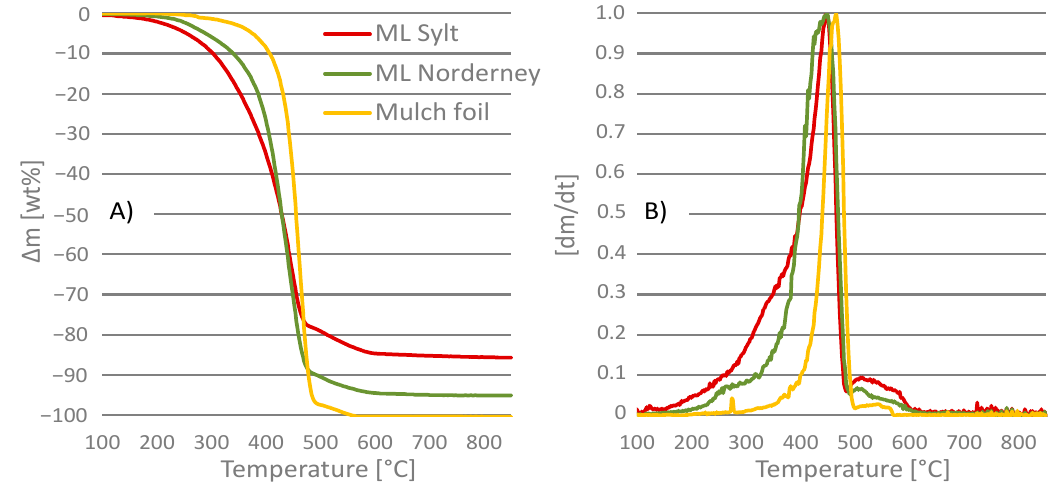
Figure 8. ( A ) shows the TGA mean value of incineration. ( B ) shows the standardised DTG signal. (ML Sylt n = 5, ML Norderney n = 5, Mulch foil n = 4).